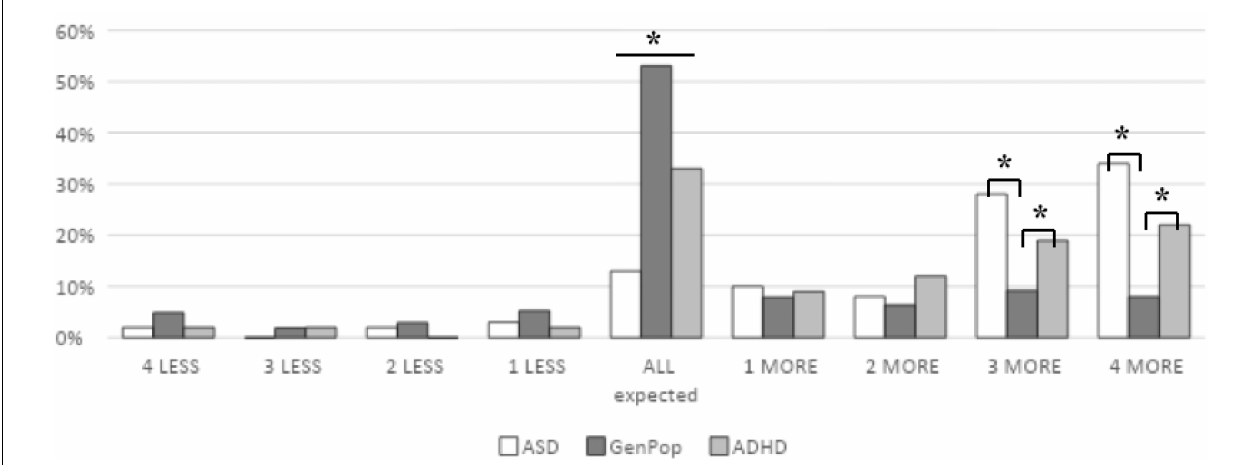
FIGURE 2 | Distribution of sensory pattern scores among three groups of children. ASD, autism; GenPop, general population; ADHD, attention deficit hyperactivity disorder. *Denotes significant differences at p < 0.05.